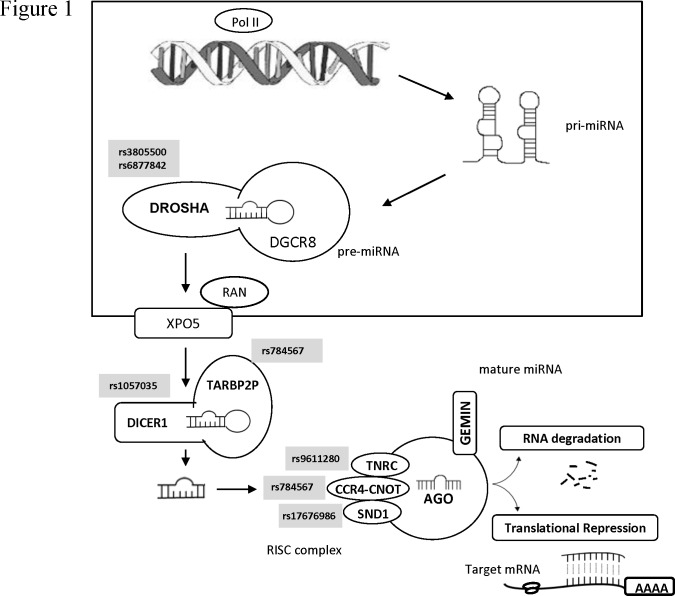
Overview of the significant SNPs in the miRNA network.